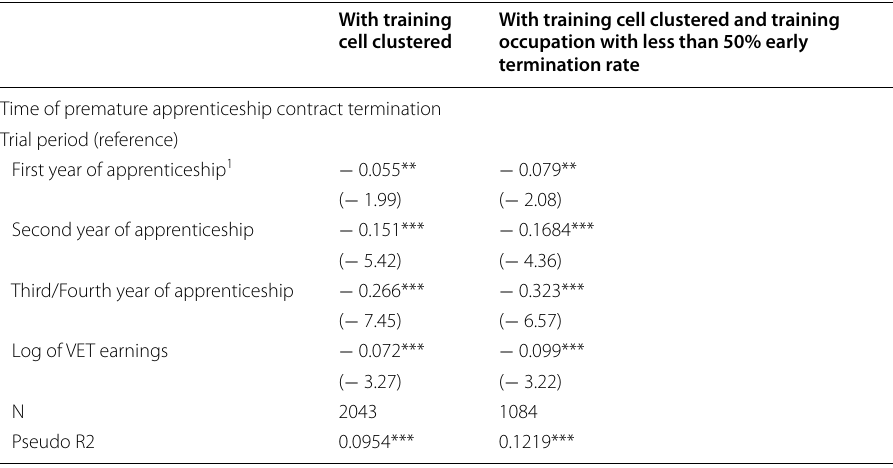
Table 6 Logit model for the probability of changing occupation by timing of termination only stopouts (marginal